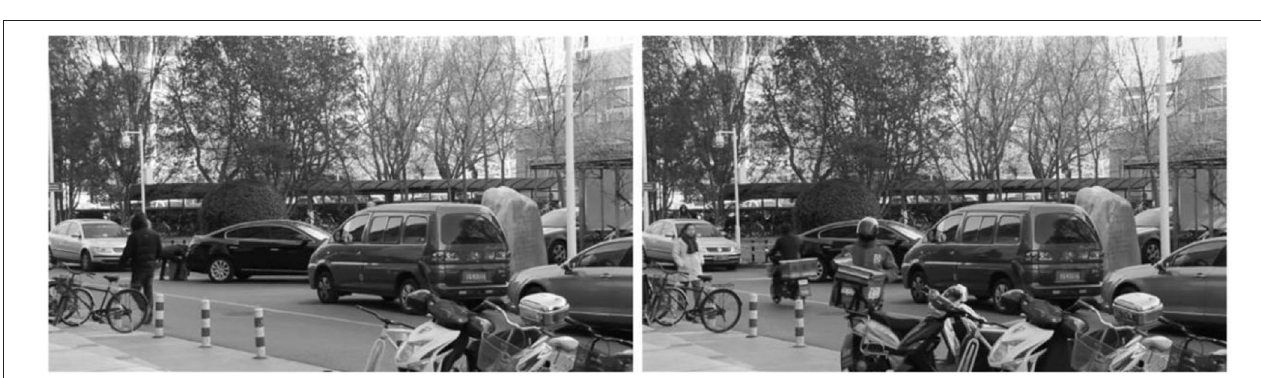
FIGURE 1 | Beginning and ending shots of the Psycho clip.